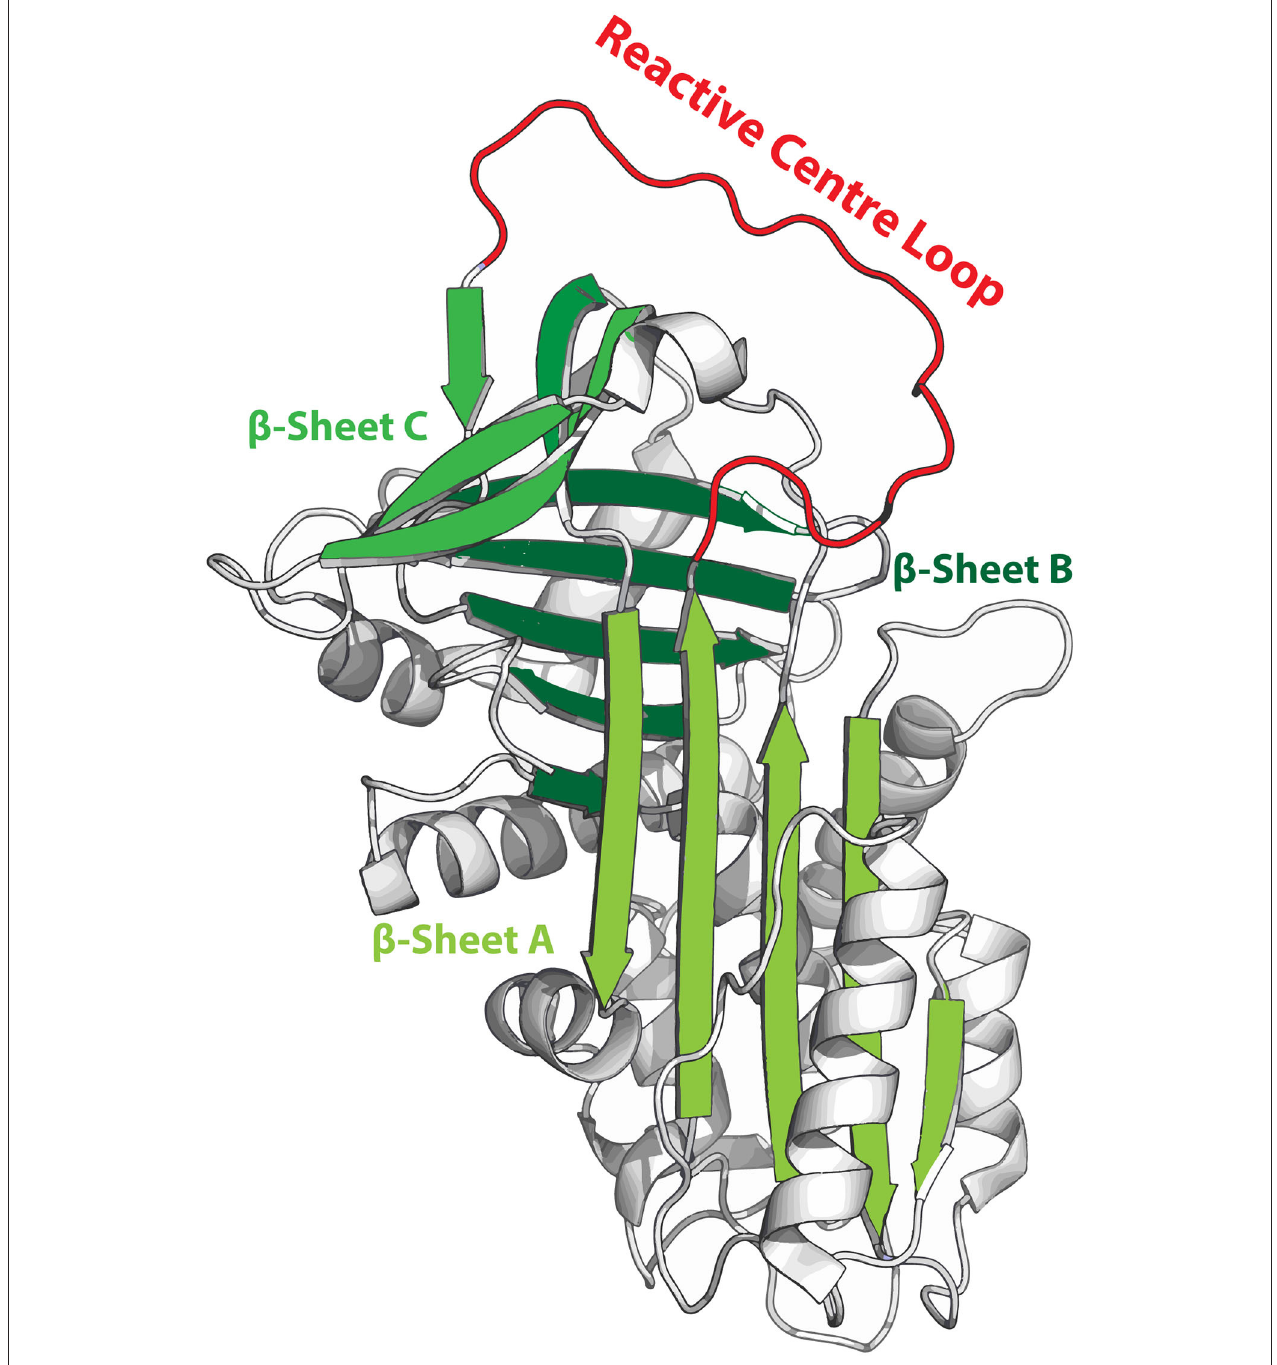
FIGURE 1 | Metastable structure of α 1-antitrypsin. β -sheets are highlighted in green and the reactive center loop (RCL) is highlighted in red. When the RCL becomes cleaved it integrates into β -sheet A, effectively becoming the 6th strand of this sheet.